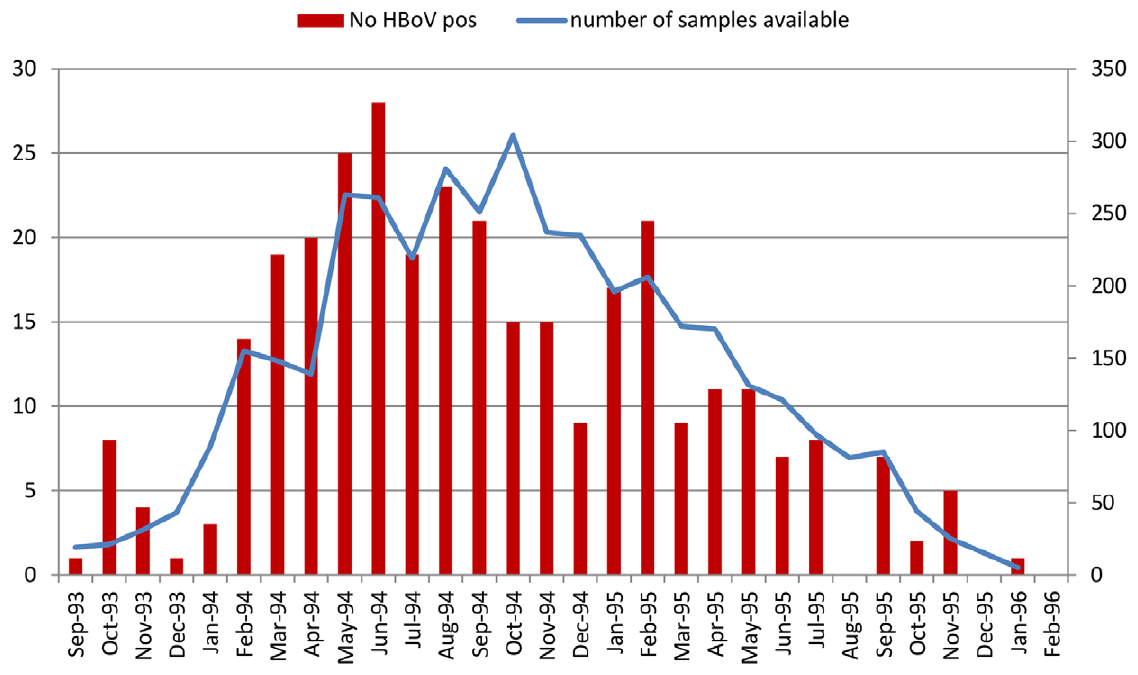
Figure 2. Temporal distribution of HBoV infections. doi:10.1371/journal.pone.0041346.g002 PLoS ONE |